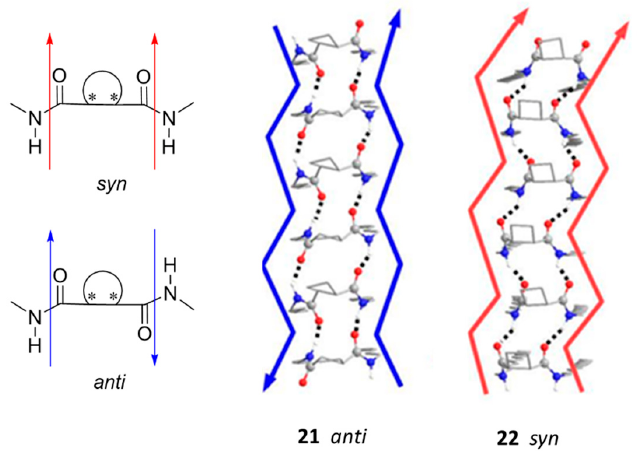
Figure 17. Left : syn and anti -disposition of amido groups. Asterisks represent the stereogenic centers. Right : predicted structures of the octameric aggregates of compounds 21 and 22 ; nonpolar hydrogen atoms have been omitted for clarity. Adapted with permission from Wiley [33].